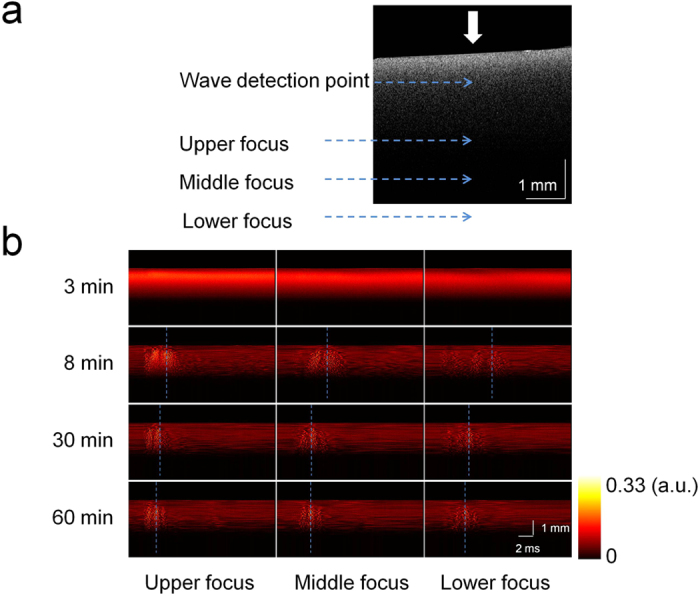
OCT and Doppler variance images for the blood coagulation measurement.(a) The OCT image at the beginning of the measurement. The ARF focus is moved downwards by a mechanical lifting stage at a step of 1mm for each measurement and the OCT M-scan is applied at the position indicated by the white arrow. (b) The Doppler variance images at four typical time points successively using three ARF focus positions. In the process of blood coagulation, the wave occurrence time of the shear wave becomes shorter, indicating a faster shear wave velocity using each of the ARF focus positions.